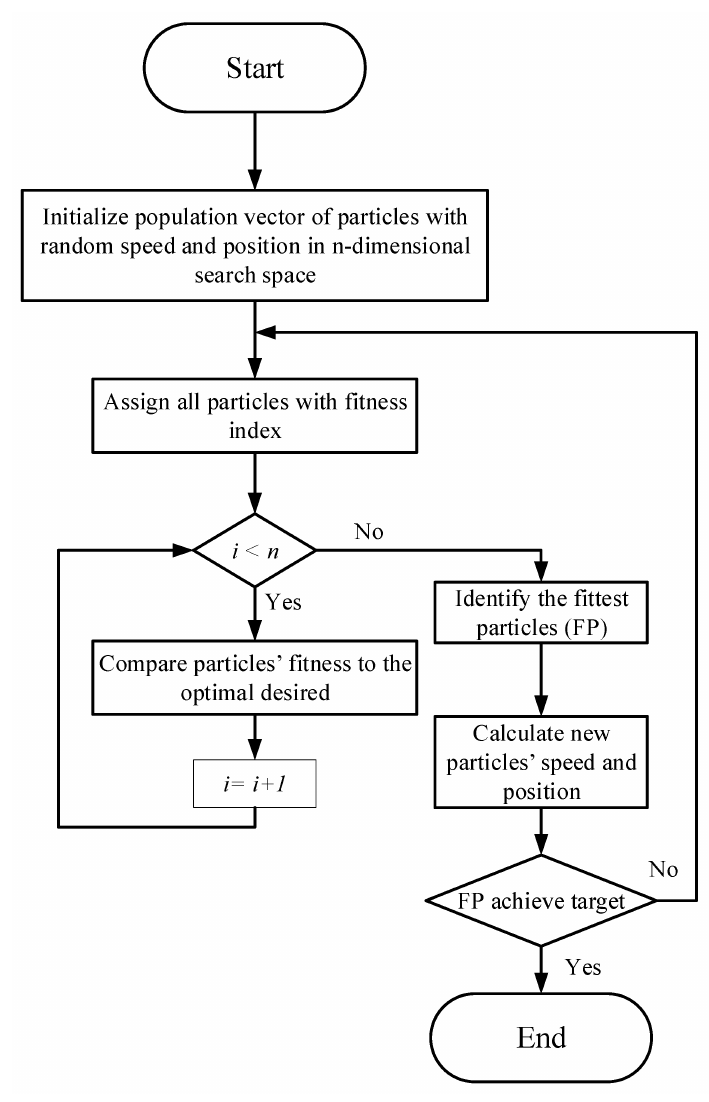
Figure 1. Original PSO algorithm presented in a simplified